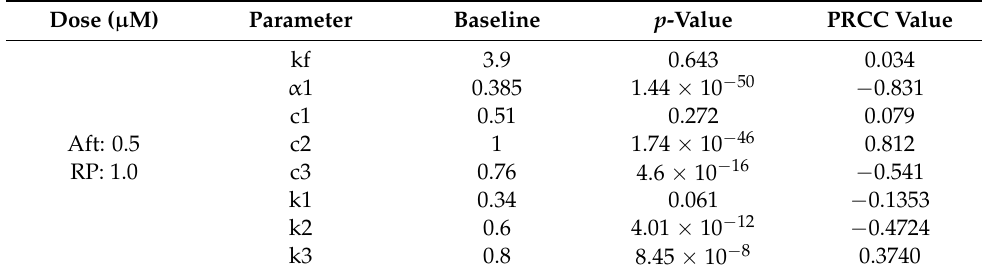
Table 3. Summary of sensitivity analysis